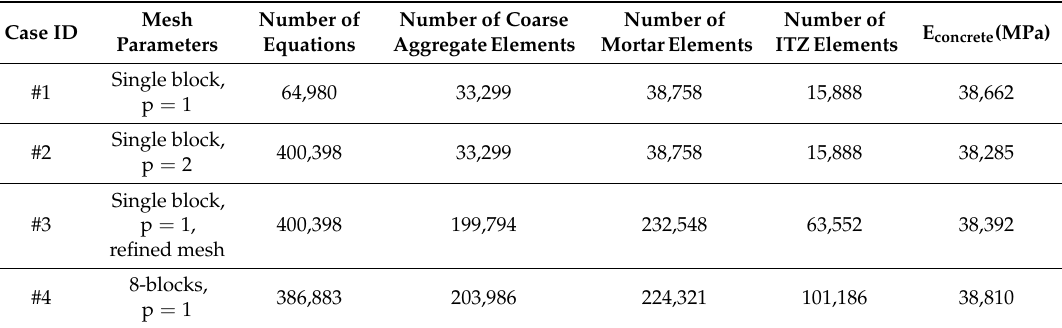
Table 1. Calculated Young’s modulus of concrete. E ITZ = 2/3 E mortar , t ITZ = 50 µ m, and E agg = 60 GPa. Experimental value is 36,360 MPa.